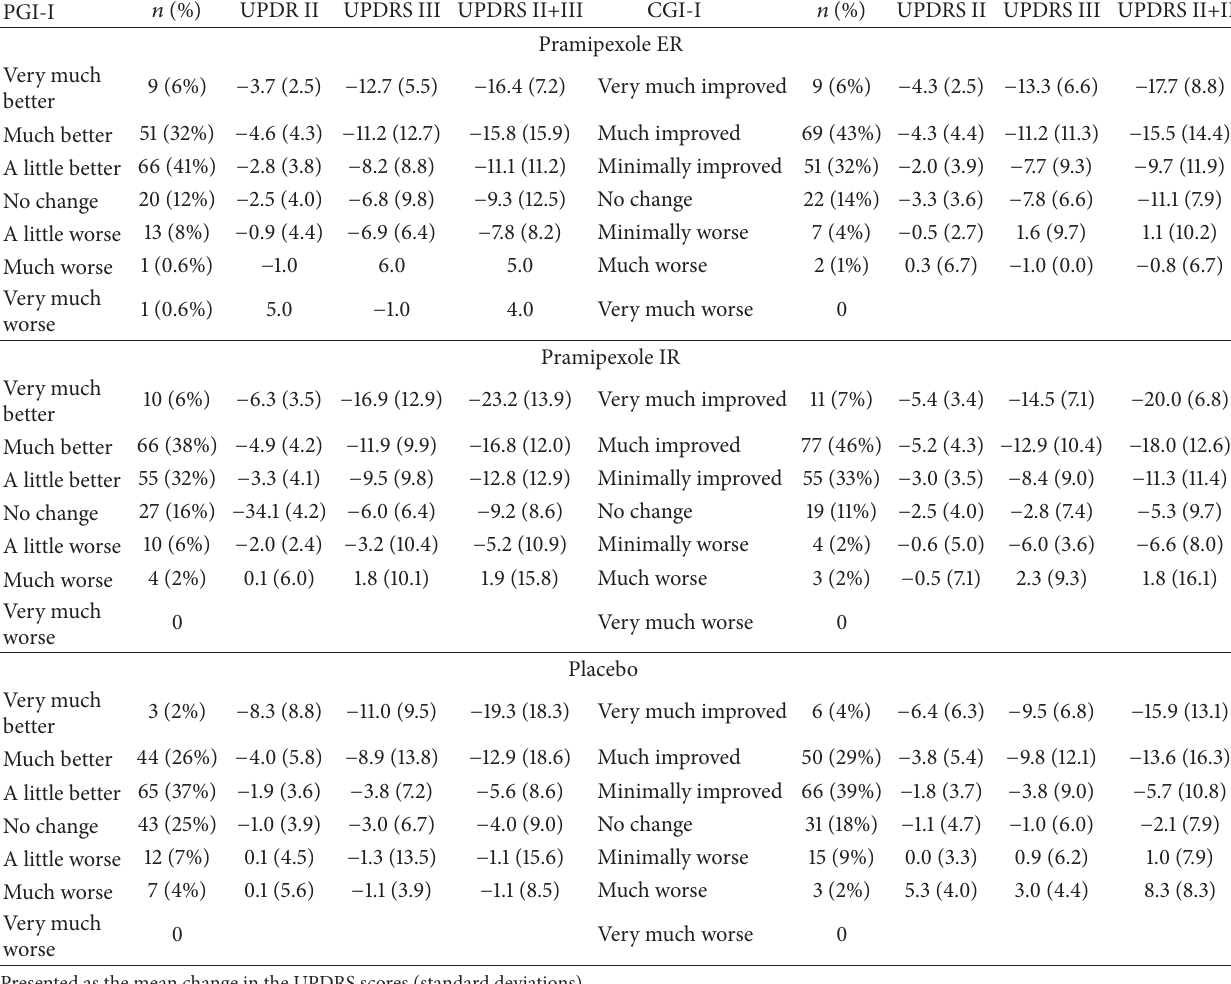
Table 2: Mean changes in UPDRS II, III, and II+III scores according to PGI-I and CGI-I ratings by treatment group in the advanced PD